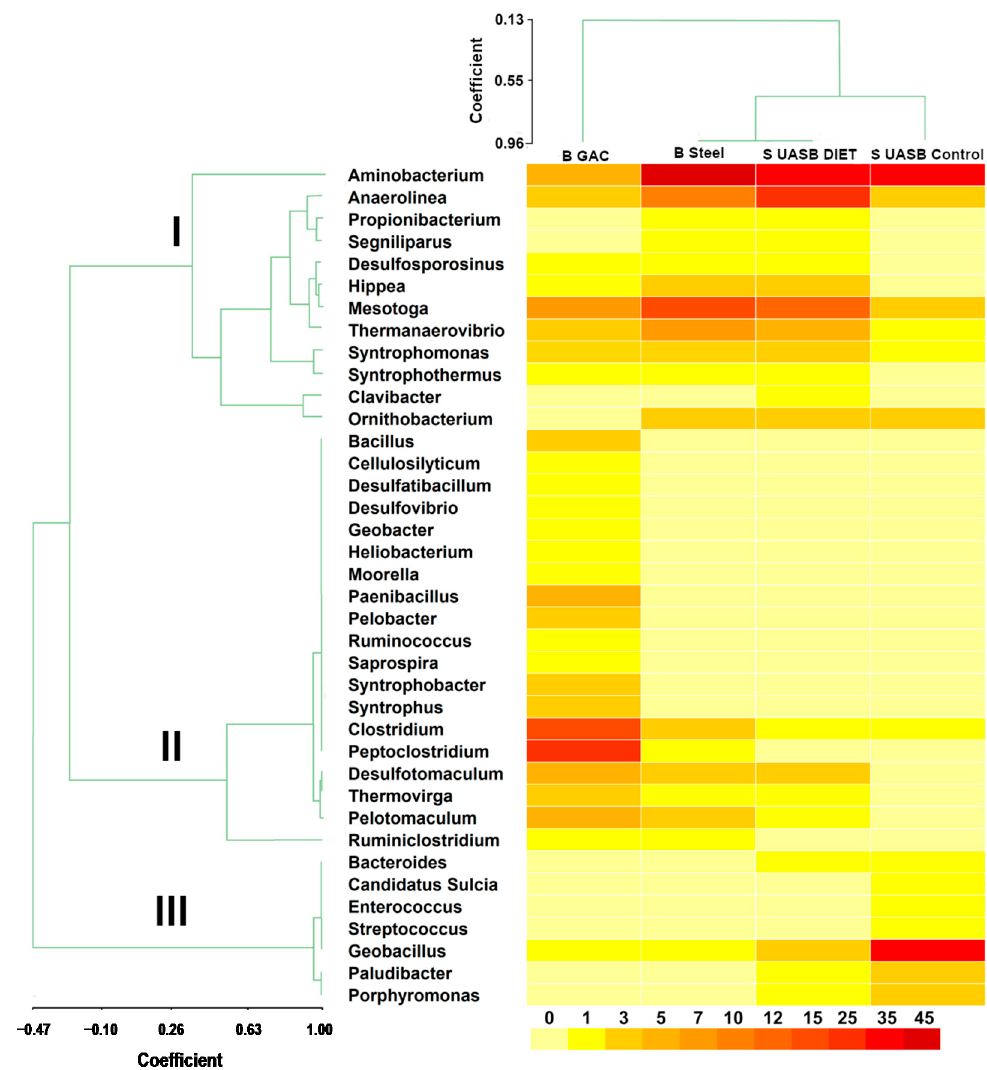
Figure 7. Heat map and dendrograms at genus level. Granulated activated carbon biofilm (B GAC), steel mesh bag biofilm (B steel), UASB DIET sludge (S UASB DIET) and UASB control sludge (S UASB control). The heatmap scale is color-coded from 0% to 45% abundance. The correlation coefficient in